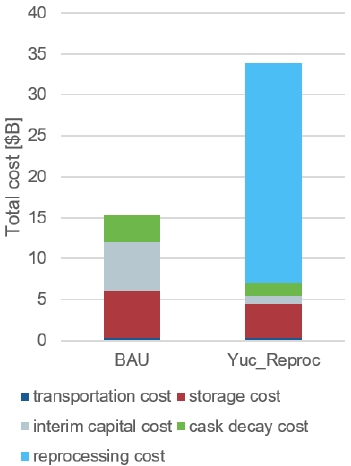
Figure 7. Comparison of the BAU and Yuc_reproc scenario. Source: own representation.